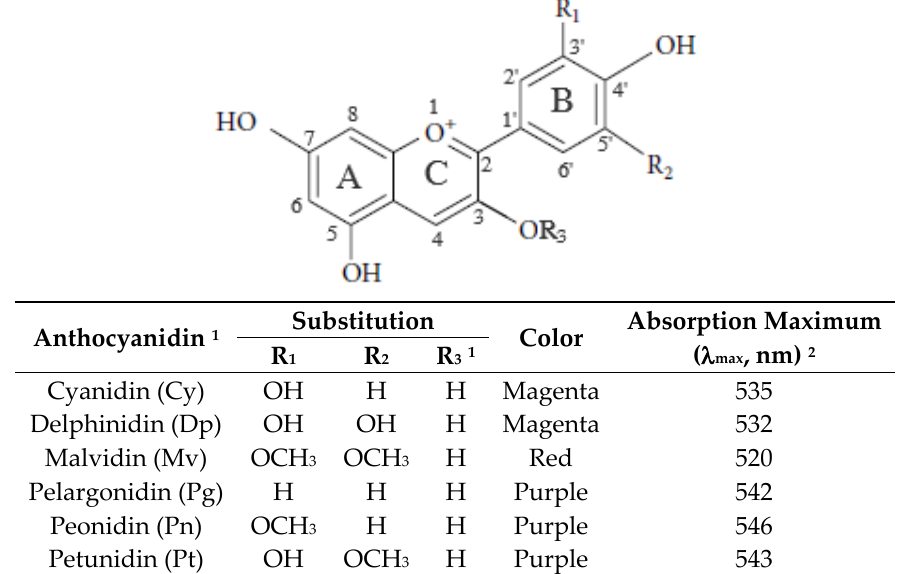
Figure 2. Chemical structure of most common anthocyanins found in fruits and vegetables.